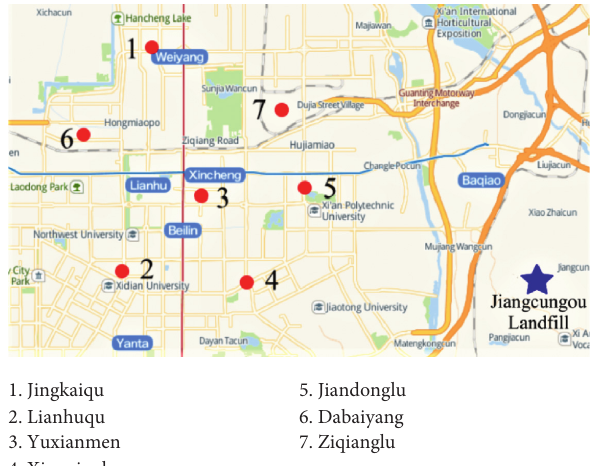
Figure 1: Locations of waste collection stations in Xi’an where municipal solid waste (MSW) samples originated (the legend provides the names of the sample